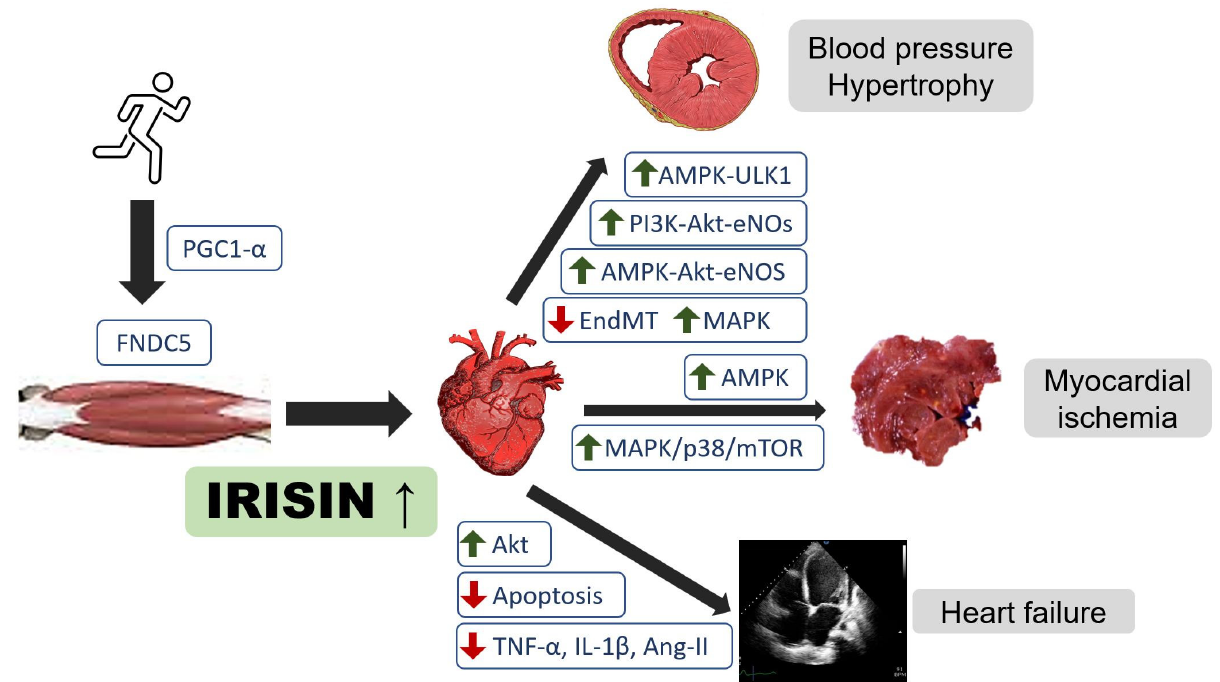
Figure 1. Regulatory role of irisin in heart failure, cardiovascular disease, and myocardial ischemia. Akt, protein kinase B; AMPK, adenosine monophosphate-activated protein kinase; eNOS, endothelial nitroxide synthase; PGC-1 α , peroxisome proliferator-activated receptor- γ coactivator-1 α ; ULK1, serine/threonine-protein kinase; EndMT, endothelial-to-mesenchymal transition; MAPK, mitogen-activated protein kinase; mTOR, mechanistic target of rapamycin.